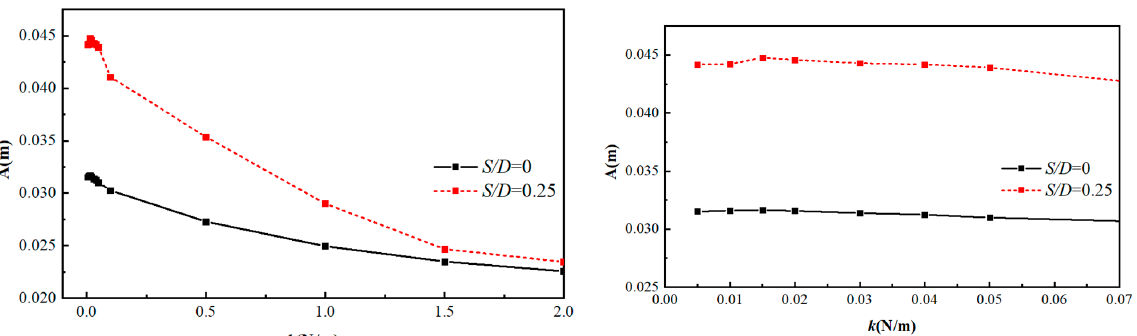
Figure 11. Vibration responses under different submerged depths ( U r = 3.36, T = 1.29 s, A W = 0.0375 m).